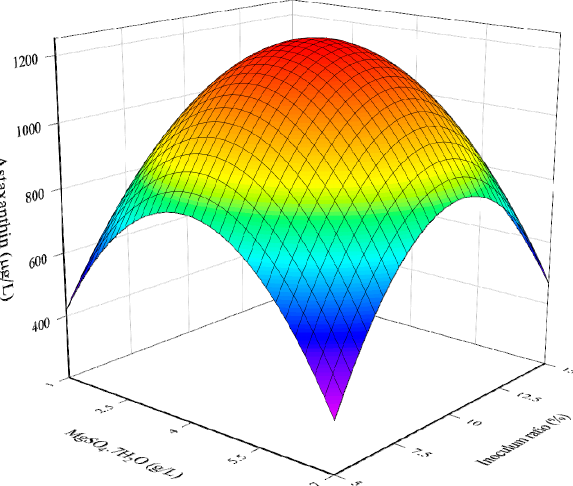
Figure 3. Combined effect of MgSO 4 · 7H 2 O concentration and inoculum ratio on the astaxanthin